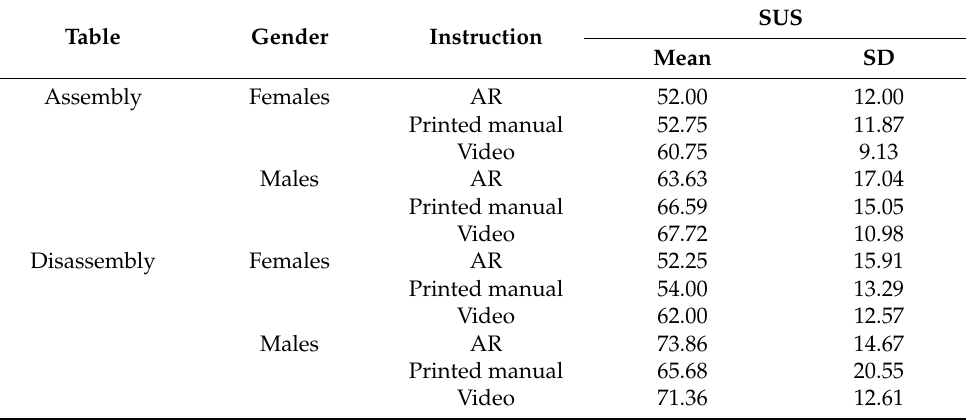
Table 6. Means and standard deviations (SD) of the SUS score. Table